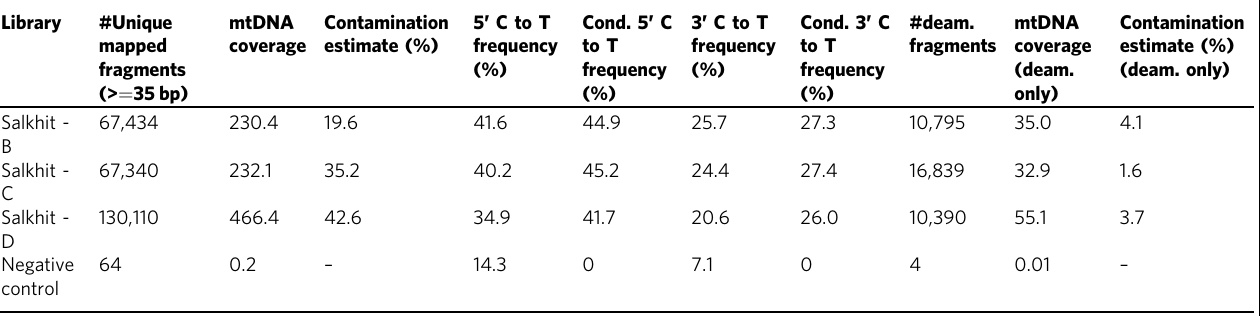
The contamination proportion is estimated based on positions 10,364 and 14,578 (in the rCRS reference genome) diagnostic of the Salkhit individual Cond. conditional, deam. deaminated